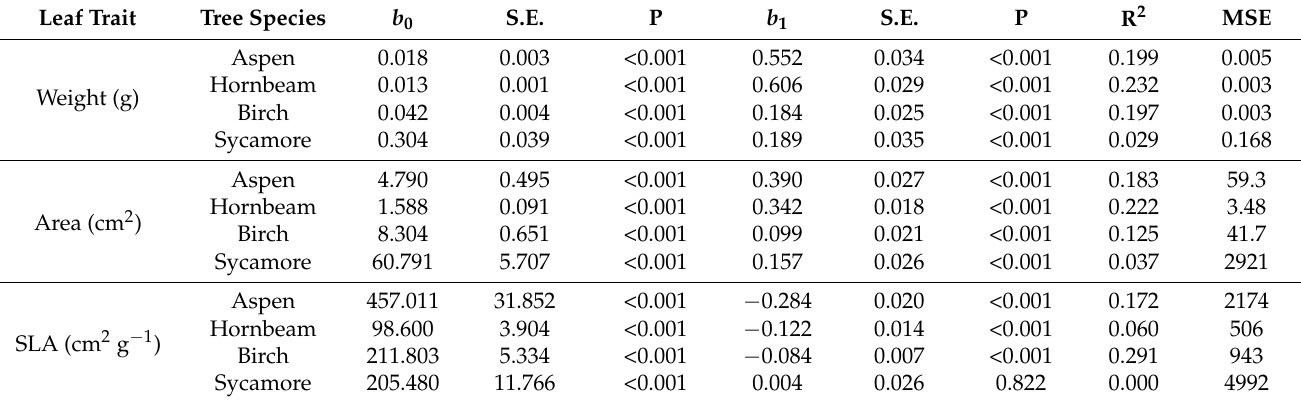
Table 2. Species-specific models for estimating individual leaf weight (g), leaf area (cm 2 ) and specific leaf area (SLA in cm 2 g − 1 ) based on using equation in Figure 1d using diameter at stem base d 0 (mm) as a predictor. Meaning of abbreviations is explained in Table